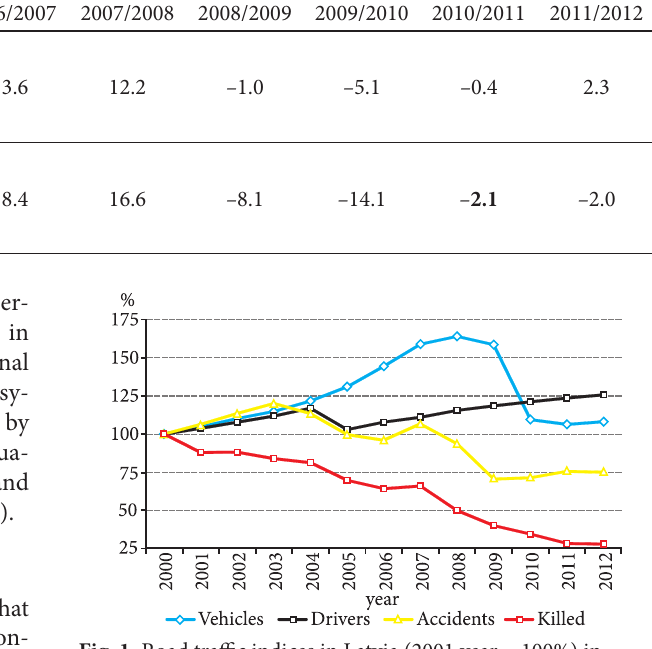
Fig. 1. Road traffic indices in Latvia (2001 year = 100%) in